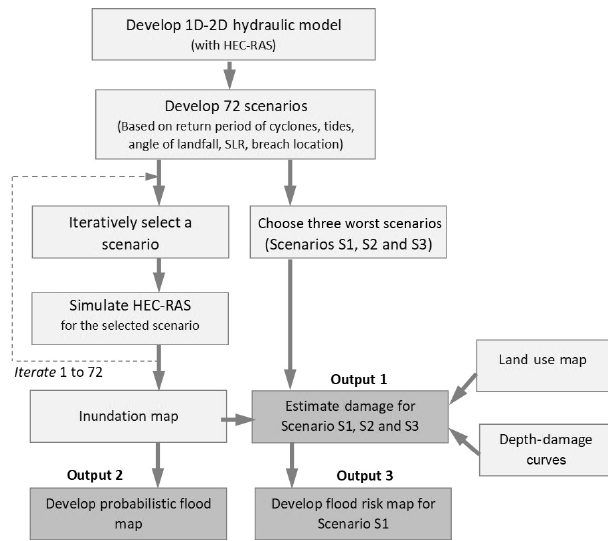
Figure 2. Methodological approach followed in this